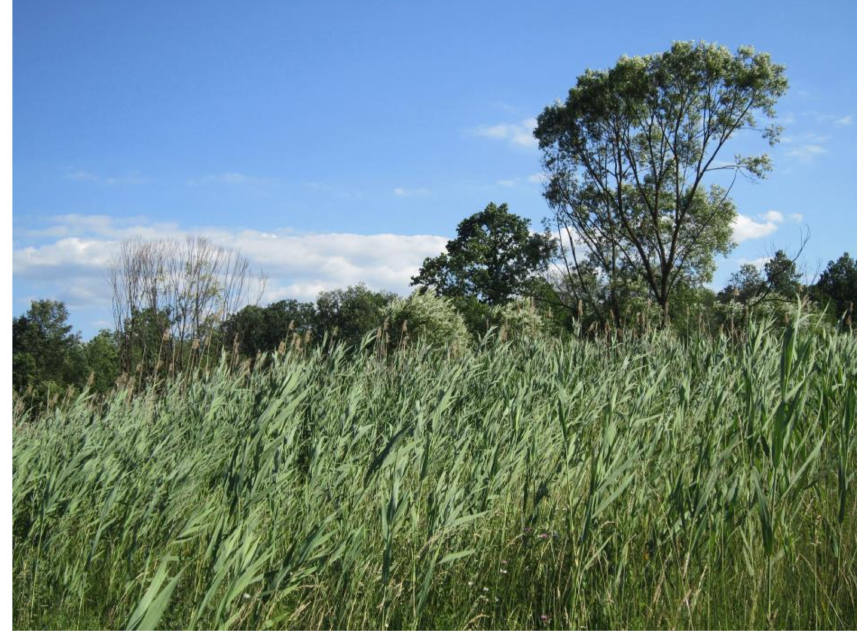
Figure 12. The association Phragmitetum australis Saviˇc 1926 (Serbia, photo V.